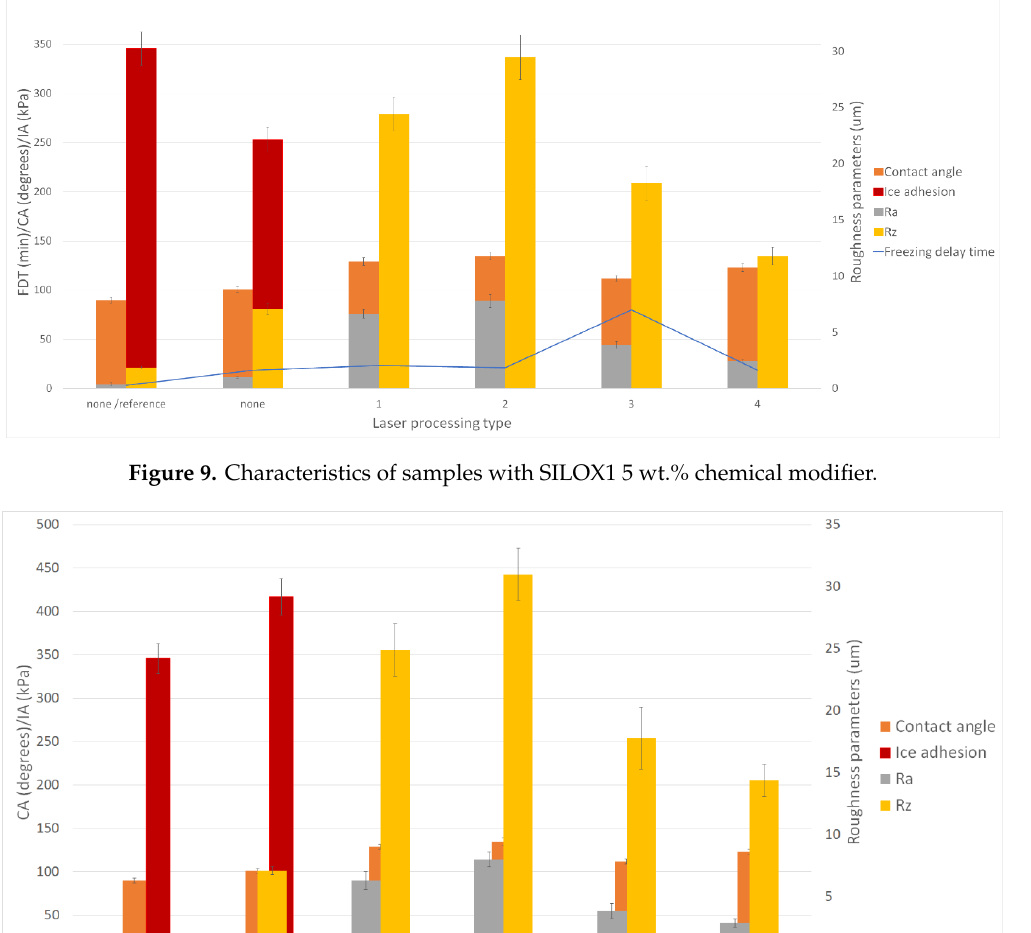
Figure 9. Characteristics of samples with SILOX1 5 wt.% chemical modifier.